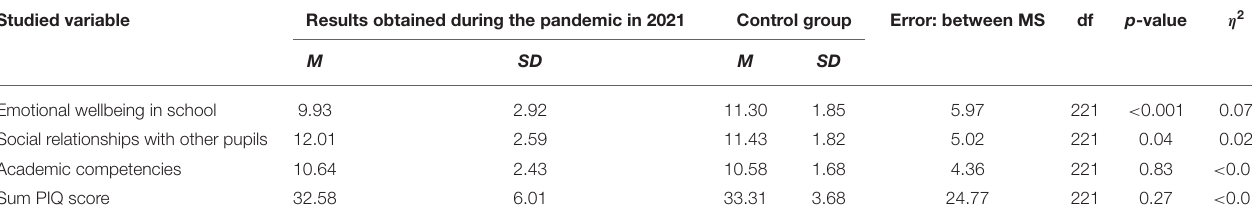
TABLE 2 | Comparison of the PIQs’ results collected during the COVID-19 pandemic in 2021 with the control group. Studied variable Results obtained during the pandemic in 2021 Control group Error: between